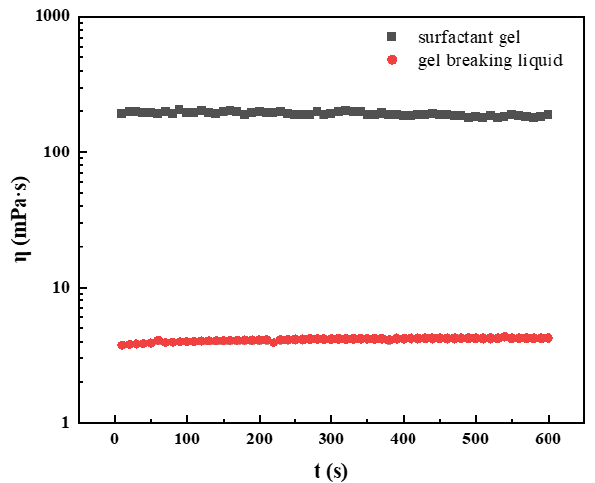
Figure 11. Viscosity variation of surfactant gel before and after breaking.